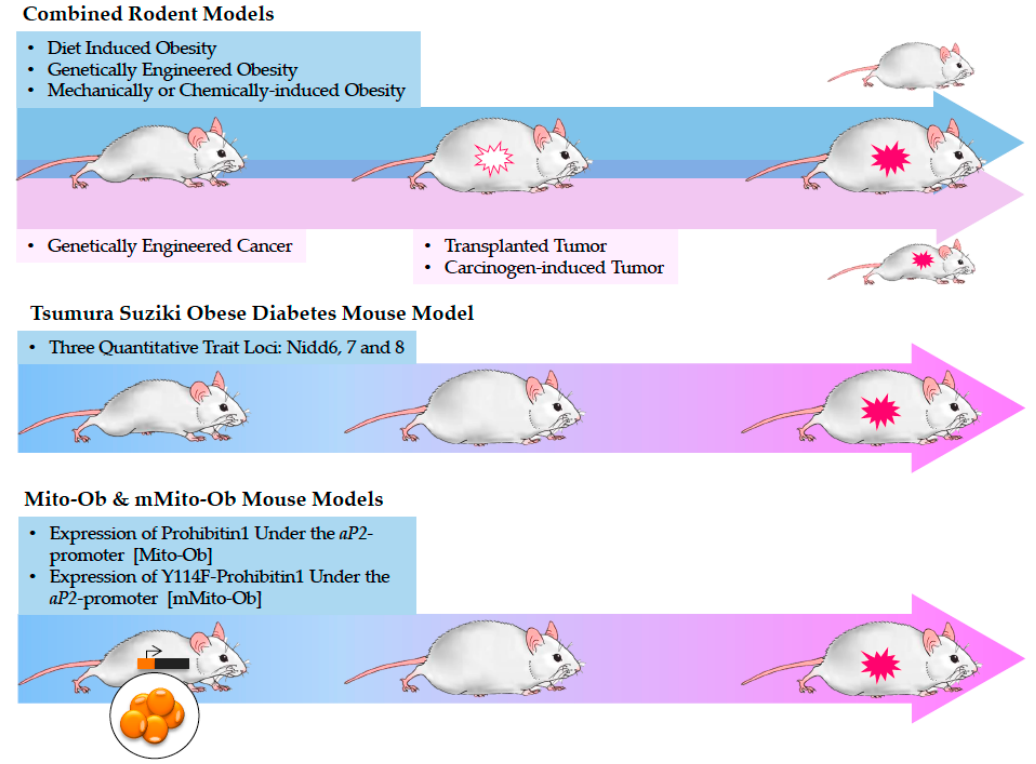
Figure 2. The development of obesity-linked tumors in combined rodent models, Tsumura Suzuki Obese Diabetes (TSOD) and Mito-Ob/mMito-Ob mouse models. Tsumura Suziki Obese Diabetes (TSOD) and Mito-Ob/mMito-Ob mouse models. The combined rodent models develop obesity and cancer through independent manipulations in genetics, diet, and inducible techniques